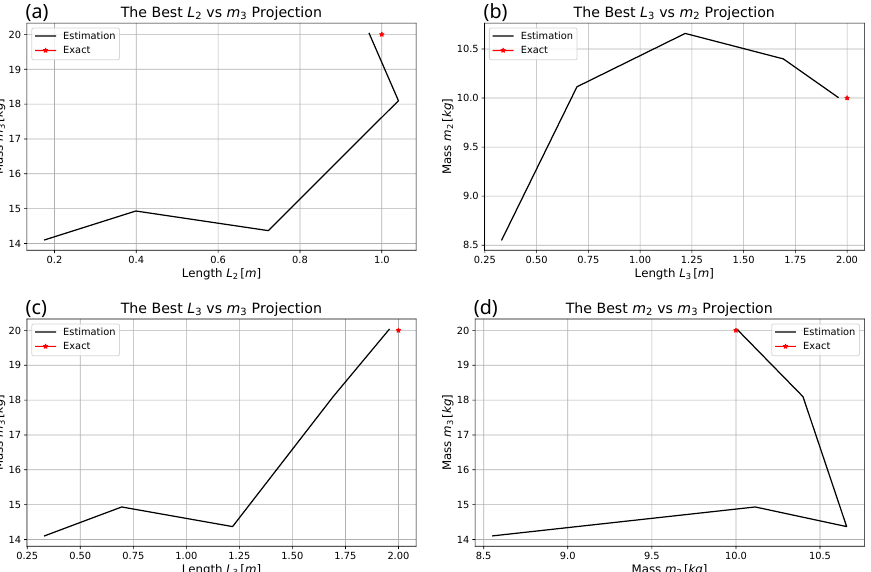
Figure 10. Projection of the estimated elements ( a ) L 2 vs. m 3 ( b ) L 3 vs. m 2 ( c ) L 3 vs. m 3 ( d ) m 2 vs. m 3